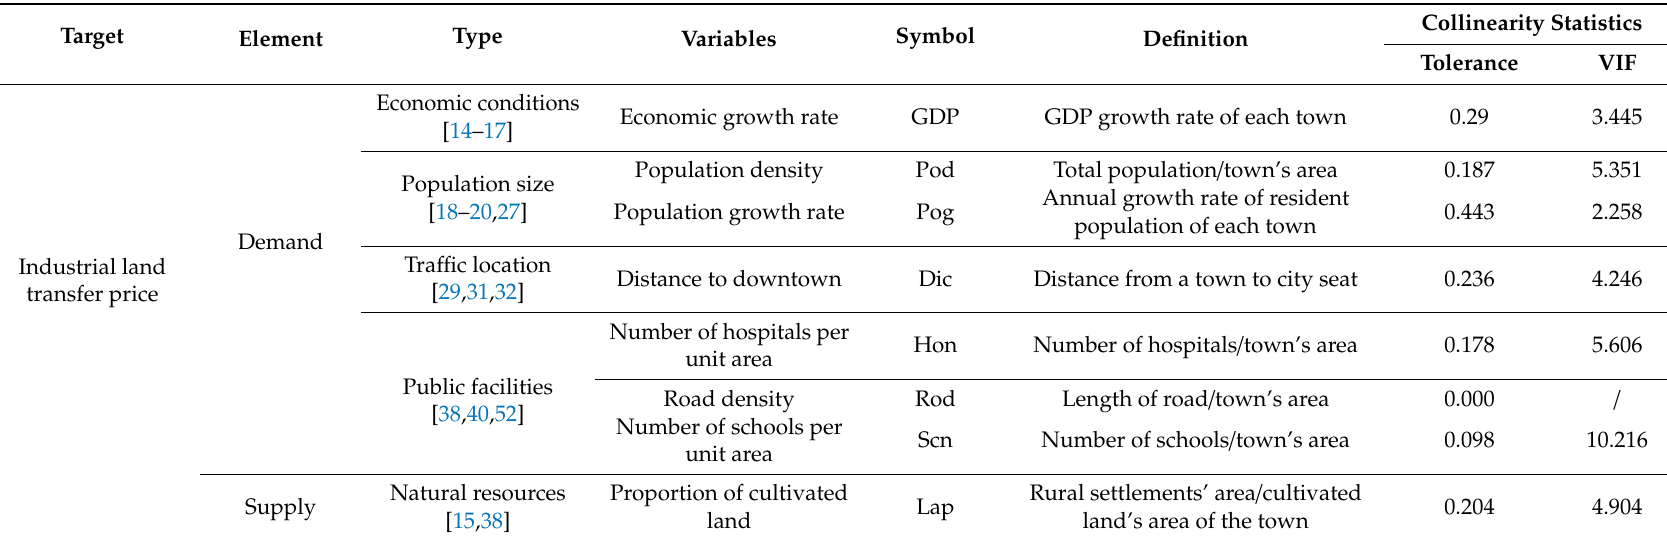
Table 1. Selection, variance inflation factor (VIF), and tolerance test of driving